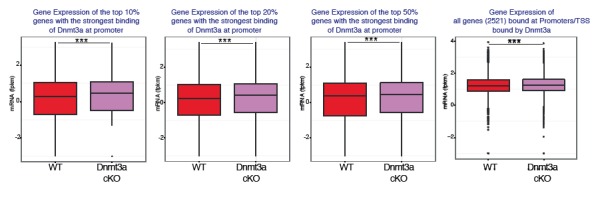
DOI:
http://dx.doi.org/10.7554/eLife.21697.039